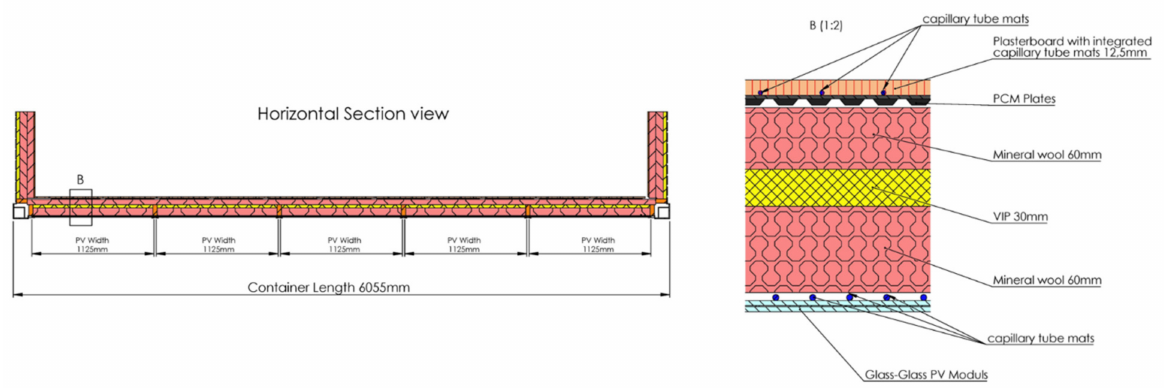
Figure 17. Construction of a side wall